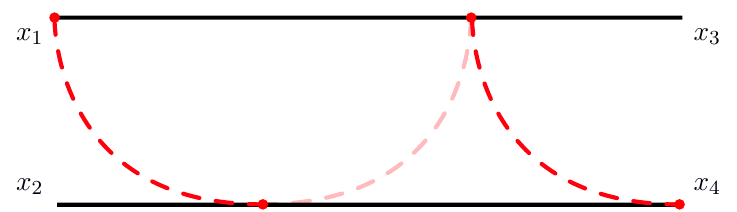
Figure 14 . An example of a fishnet ladder diagram evaluated in the computation of G ( z, z ) with one-magnon operators. The four-point interaction sites have coupling ξ 2 so this diagram contributes at order ξ 4 and the shading of the propagator indicates how it “winds”. The points x 1 and x 2 “source” the propagator and account for the modified scaling dimensions of the operators inserted at these points (see [14] for additional diagrams and